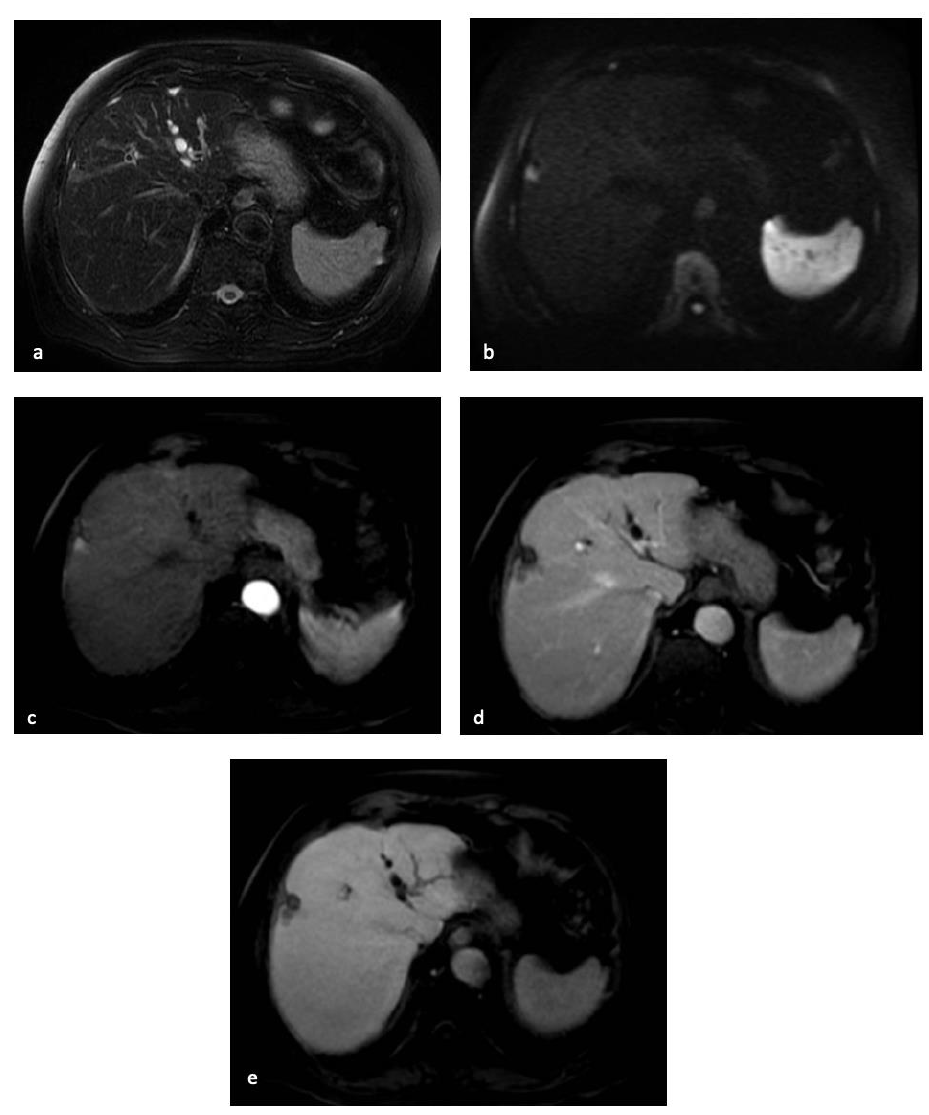
Figure 3. MR examination of the patient discussed in Figures 1 and 2. On T2-weighted images, the centimetric subcapsular appeared as hyperintense ( a ). On DWI with a b-value of 1000, the lesion showed signal restriction ( b ). After administration of a hepatobiliary contrast agent, the lesion showed arterial hyperenhancement ( c ) with hypointensity in the portal-venous phase ( d ) and in the hepatobiliary phase. ( e ) The lesion appeared hypointense.